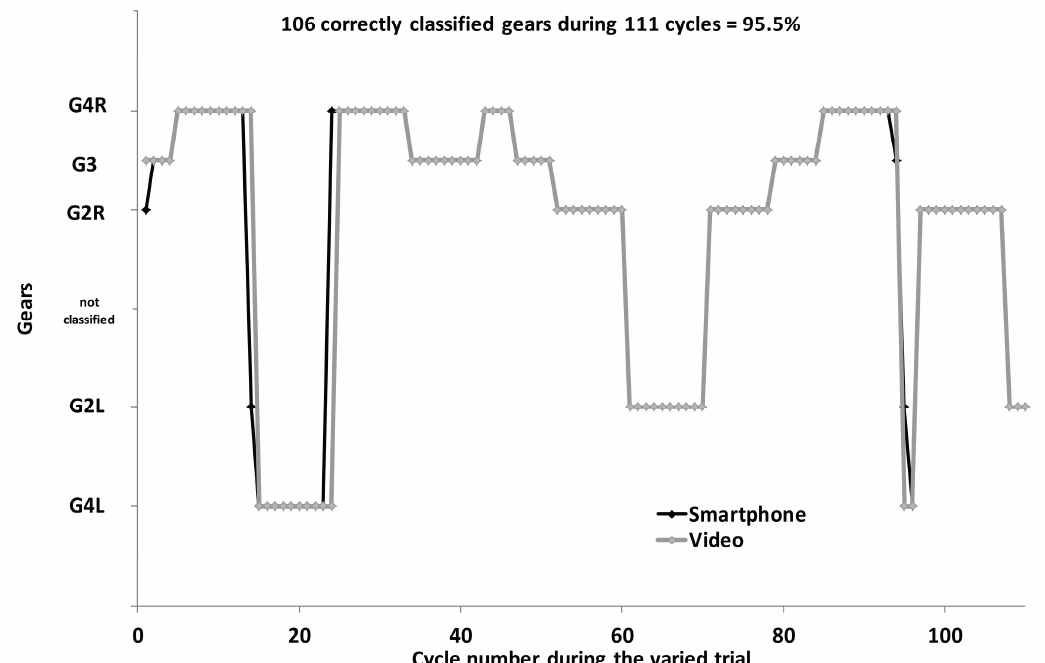
Figure 6. Comparison of automated gear classification using acceleration data from the Smartphone (black line and dots) with the video analysis (grey line and dots) for one of the best skiers.